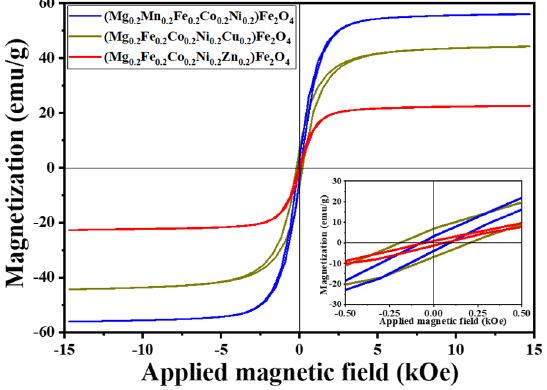
Fig. 6 Hysteresis loops of HE MFe 2 O 4 samples.